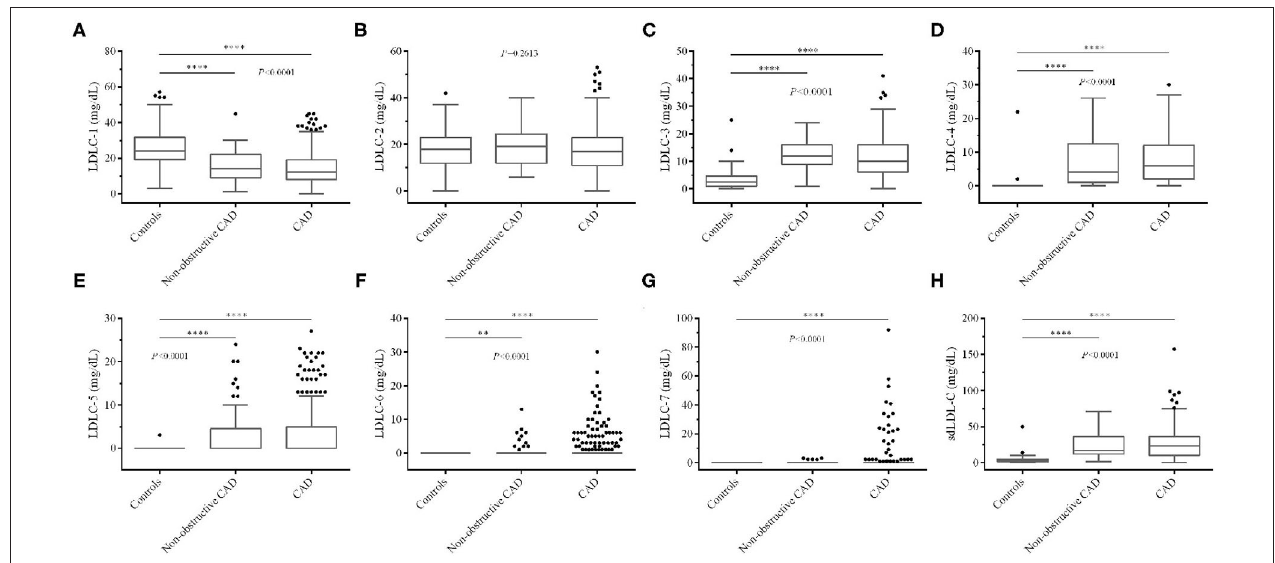
FIGURE 3 | Comparison of LDL-C subfraction levels among controls and non-obstructive and significant CAD patients. (A) LDLC-1, (B) LDLC-2, (C) LDLC-3, (D) LDLC-4, (E) LDLC-5, (F) LDLC-6, (G) LDLC-7, (H) sdLDL-C. LDL-C, low-density lipoprotein cholesterol; CAD, coronary artery disease. * P < 0.05, ** P < 0.01, *** P < 0.001, **** P <